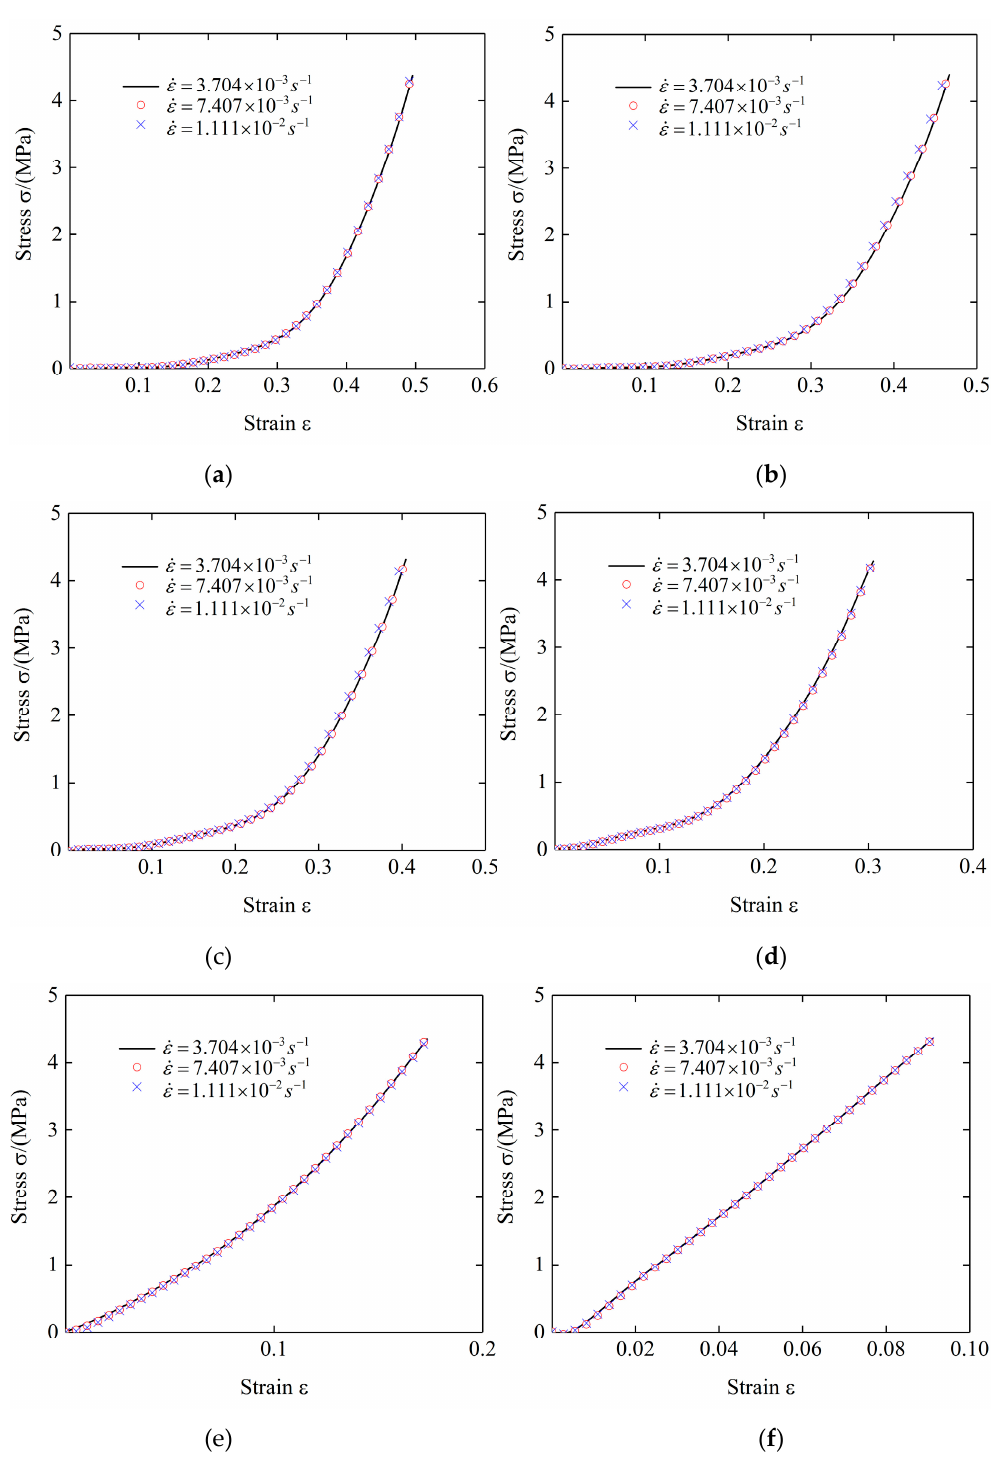
Figure 11. Stress–strain curves at different strain rates: ( a ) 20 °C; ( b ) 100 °C; ( c ) 200 °C; ( d ) 300 °C; ( e ) 400 °C; ( f ) 500 °C.